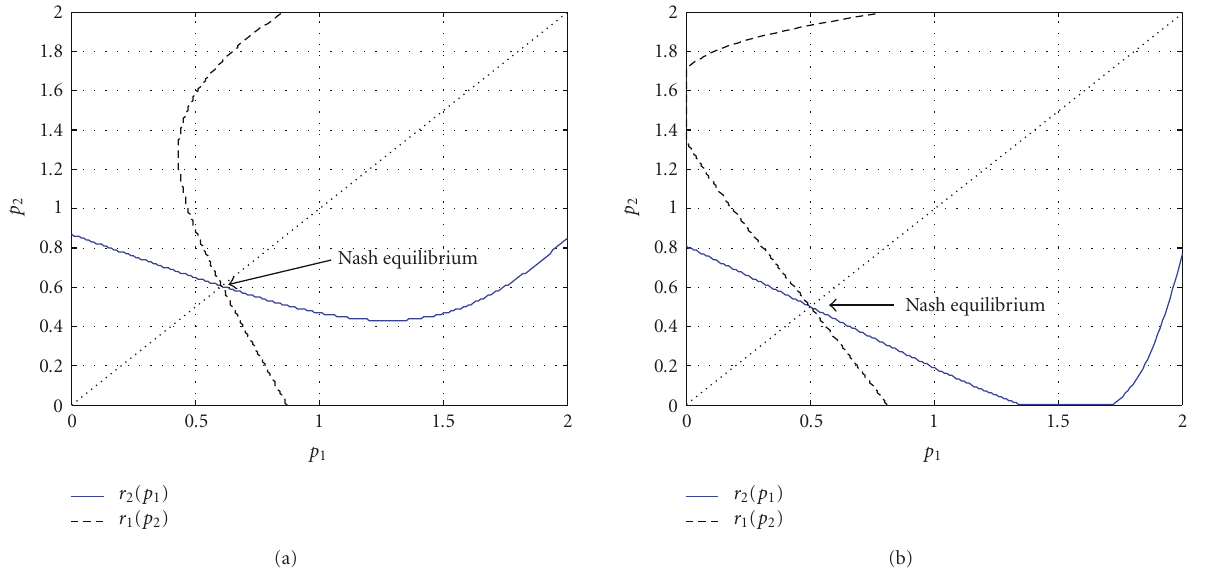
Figure 1: The uniqueness of Bayesian equilibrium. (a) g − = 1, g + = 3, (b) g − = 1, g + = 10.